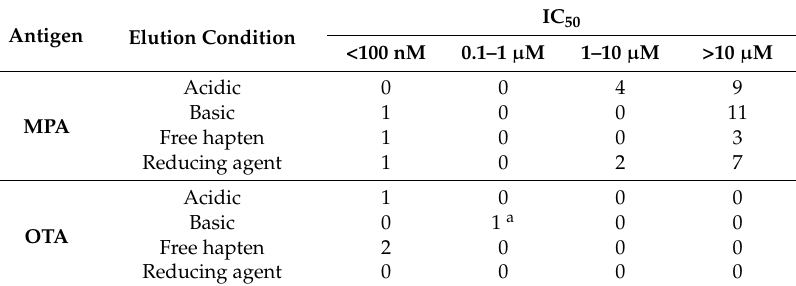
Table 3. Distribution of the competitive ELISA results and corresponding elution conditions.